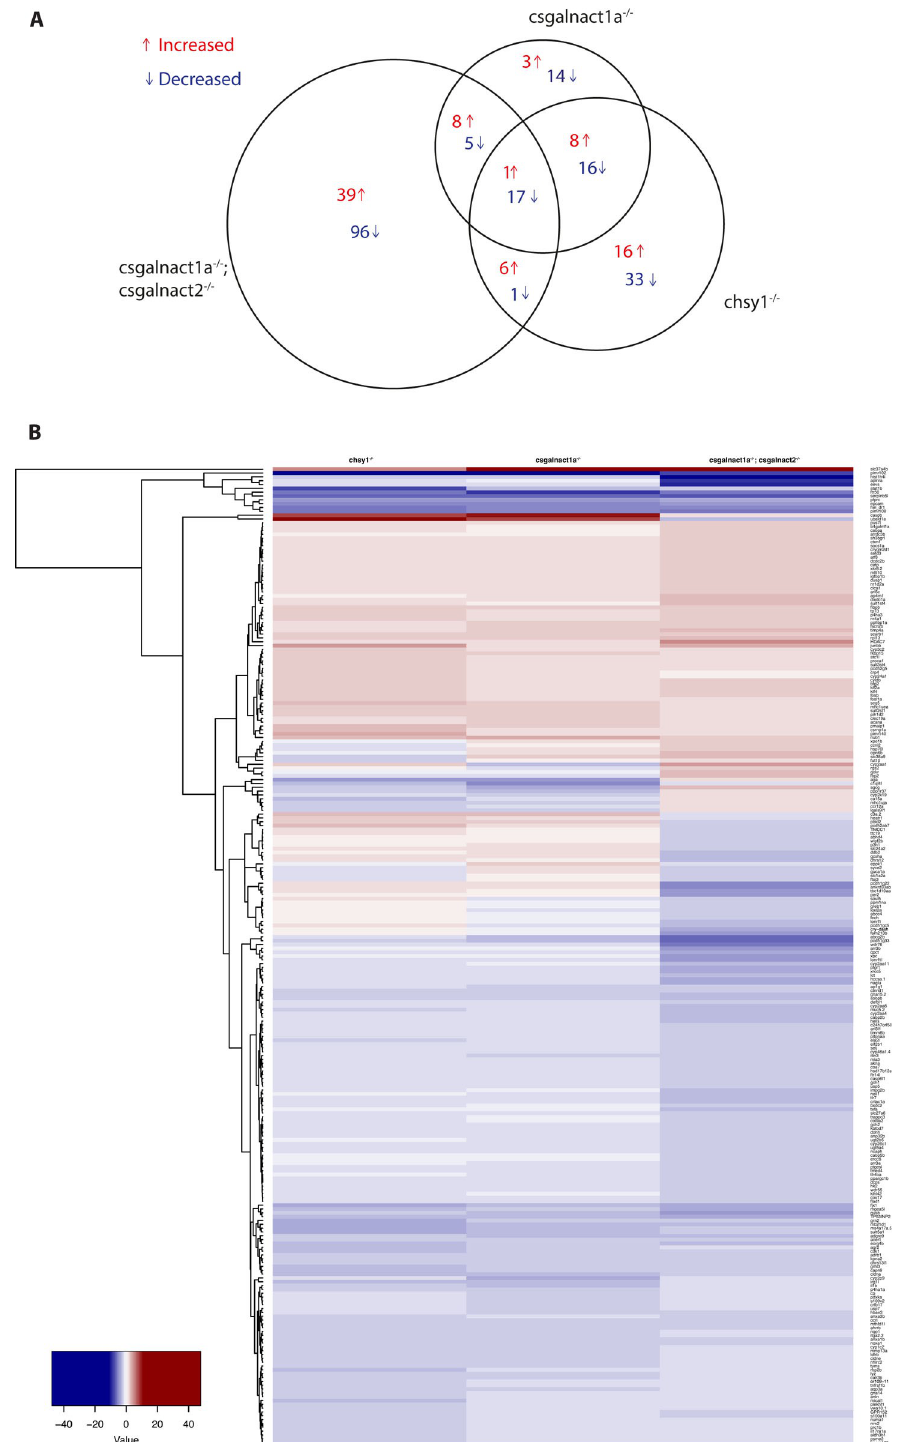
Fig 8. The area proportional venn diagram (A) shows differentially expressed genes in csgalnact1a -/- � , csgalnact1a -/- ; csgalnact2 -/- and chsy1 -/- larvae compared to control larvae. The heat map (B) shows all genes with a two-fold increase (red) or decrease (blue) in the csgalnact1a -/- , csgalnact1a -/- ;csgalnact2 -/- or chsy1 -/- larvae. � 50% of the csgalnact1a -/- individuals lack one functional allele of